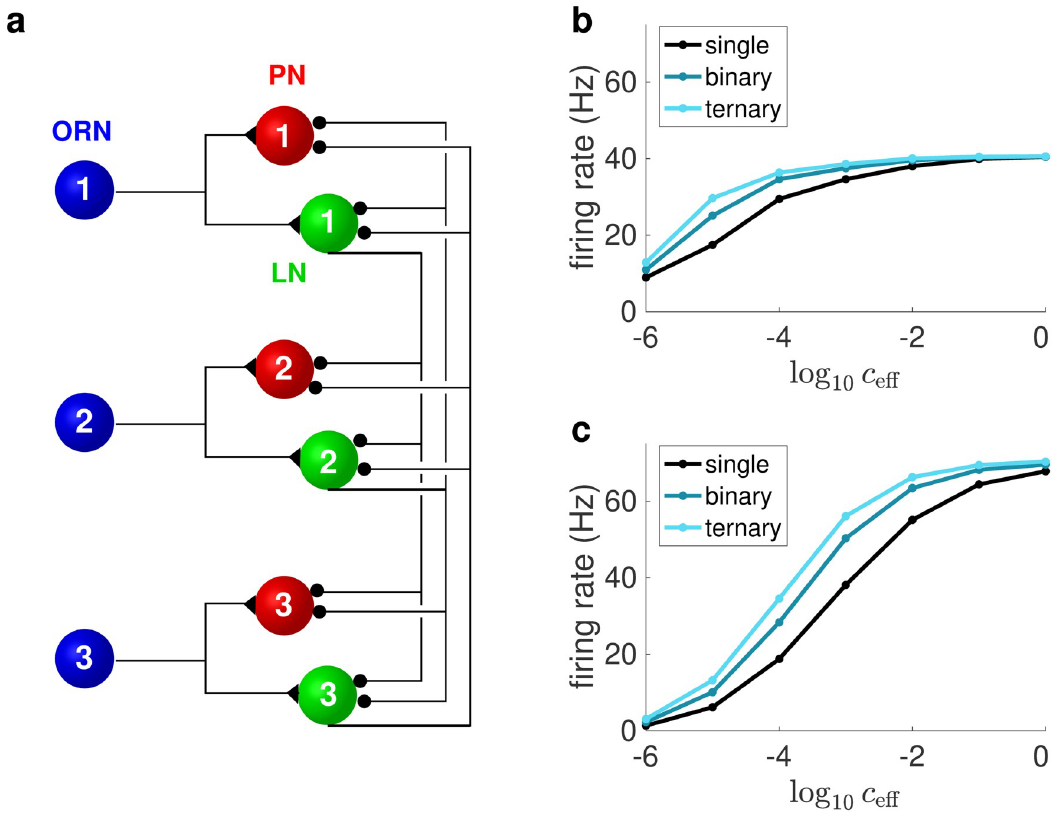
Fig 2. Average firing rate responses of ORNs and PNs to single odorants and mixtures. ( a ) Illustration of the model AL network. ORNs excite LNs and PNs of ‘their’ glomerulus, and LNs then project with inhibitory synapses to the PNs and LNs of other glomeruli. There are 160 ORN types and corresponding postsynaptic PNs and LNs in the full model, of which three are illustrated here. ( b-c ) The relationships between the stimulus concentration and the average firing rate response for ( b ) ORN and ( c ) PN, across all different odor-receptor combinations. The average responses for binary and ternary mixtures are larger than those for the components but smaller than twice and triple those of single odorants at low stimulus concentrations. They, however, become almost identical at high stimulus